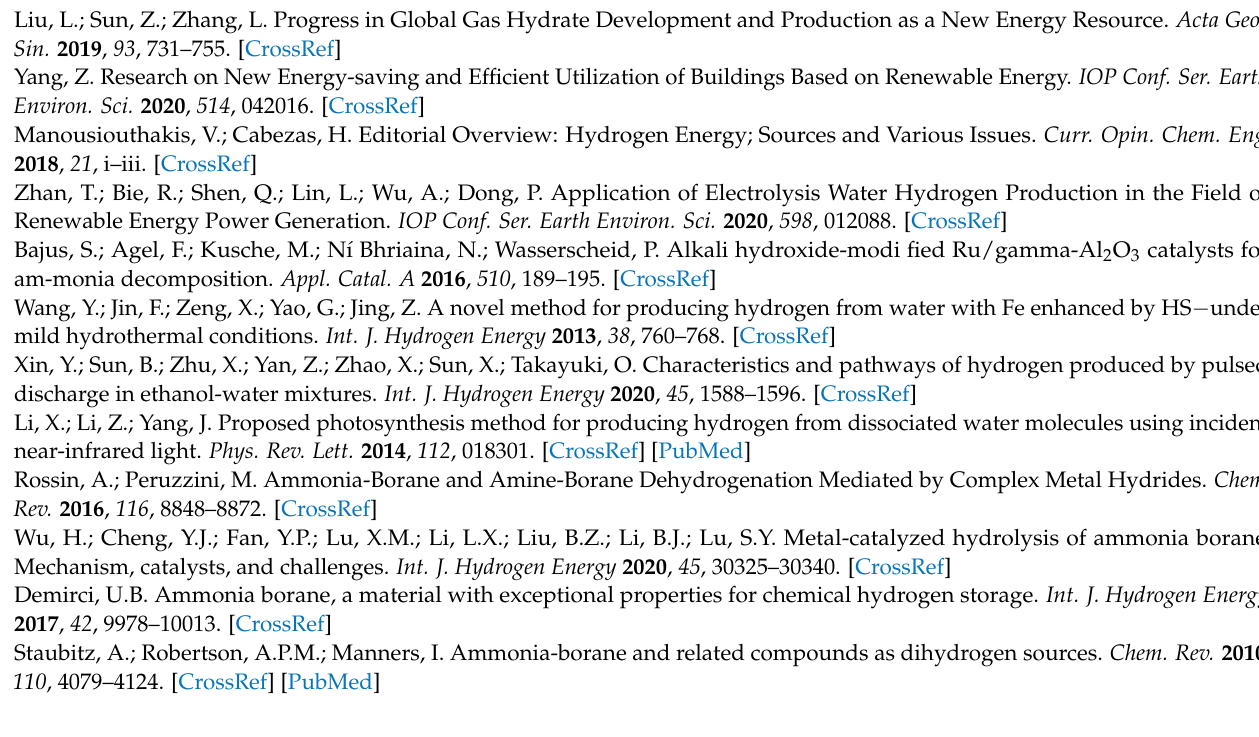
Figure S10: The energy profiles of NH 3 BH 3 dehydrogenation reaction catalyzed by CoP Ga-N ; Figure S11: Schematic diagram of energy band structure(EBS) and density of states(DOS). (subscript 1 is EBS, subscript 2 is DOS, (a), (b), (c), (d), (e) refer to CoP, CoP Ni-N , CoP Ga-N , CoP Ni-S , CoP Zn-S respectively); Table S1: Bond lengths (nm) of various sites in the reaction of NH 3 BH 3 cat- alyzed by CoP; Table S2: Bond lengths (nm) of various sites in the reaction of NH 3 BH 3 catalyzed by CoP Ni-N ; Table S3: Bond lengths (nm) of various sites in the reaction of NH 3 BH 3 catalyzed by CoP Ga-N ; Table S4: Bond lengths (nm) of various sites in the reaction of NH 3 BH 3 catalyzed by CoP Ni-S ; Table S5: The each position energies (E), relative energies (E rel ) and activation energies (E a ) of ammoborane reaction catalyzed by CoP; Table S6: The each position energies (E), relative energies (E rel ) and activation energies (E a ) of ammoborane reaction catalyzed by CoP Ni-N ; Table S7: The each position energies (E), relative energies (E rel ) and activation energies (E a ) of ammoborane reaction catalyzed by CoP Ga-N ; Table S8: The each position energies (E), relative energies (E rel ) and activation energies (E a ) of ammoborane reaction catalyzed by CoP Ni-S